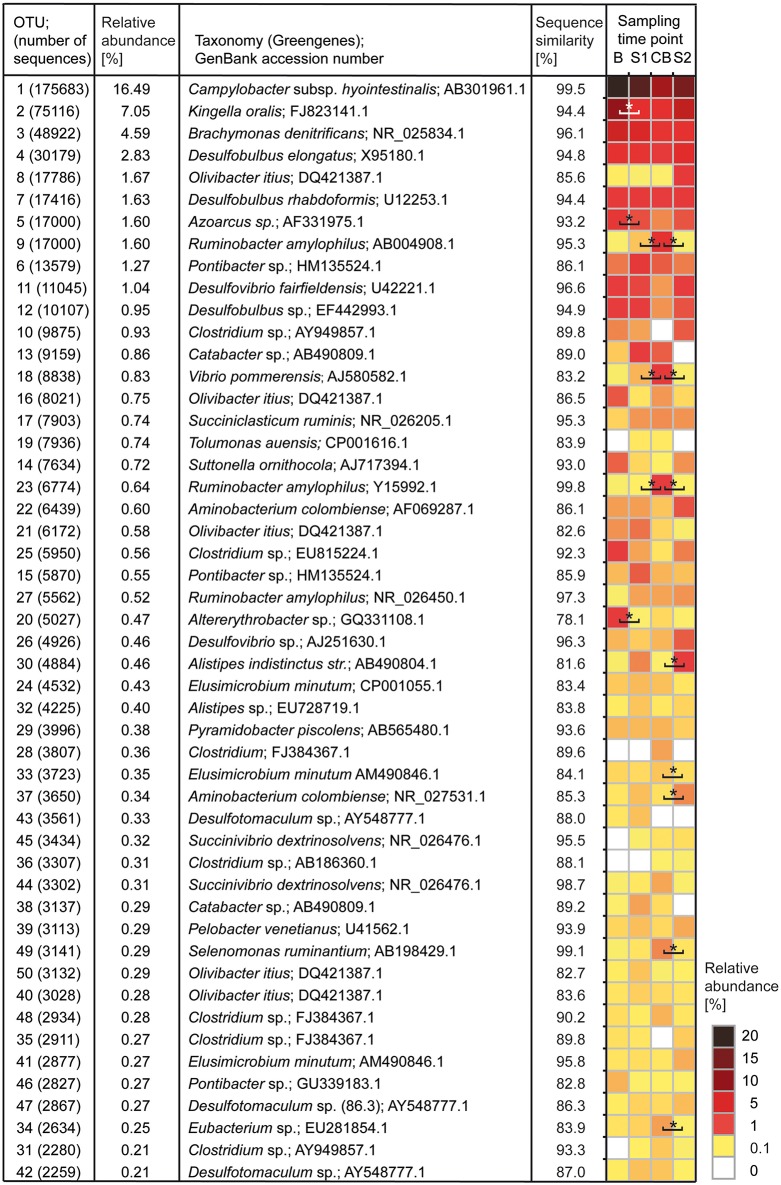
Heatmap showing the 50 most abundant OTUs with relative abundance and best Greengenes type strain hit. OTUs are sorted according to relative abundance. Statistically significant shifts between two sampling time points are marked with an asterisk. Sampling time points are as follows: B (baseline), S1 (SARA 1), CB (challenge break), and S2 (SARA 2).